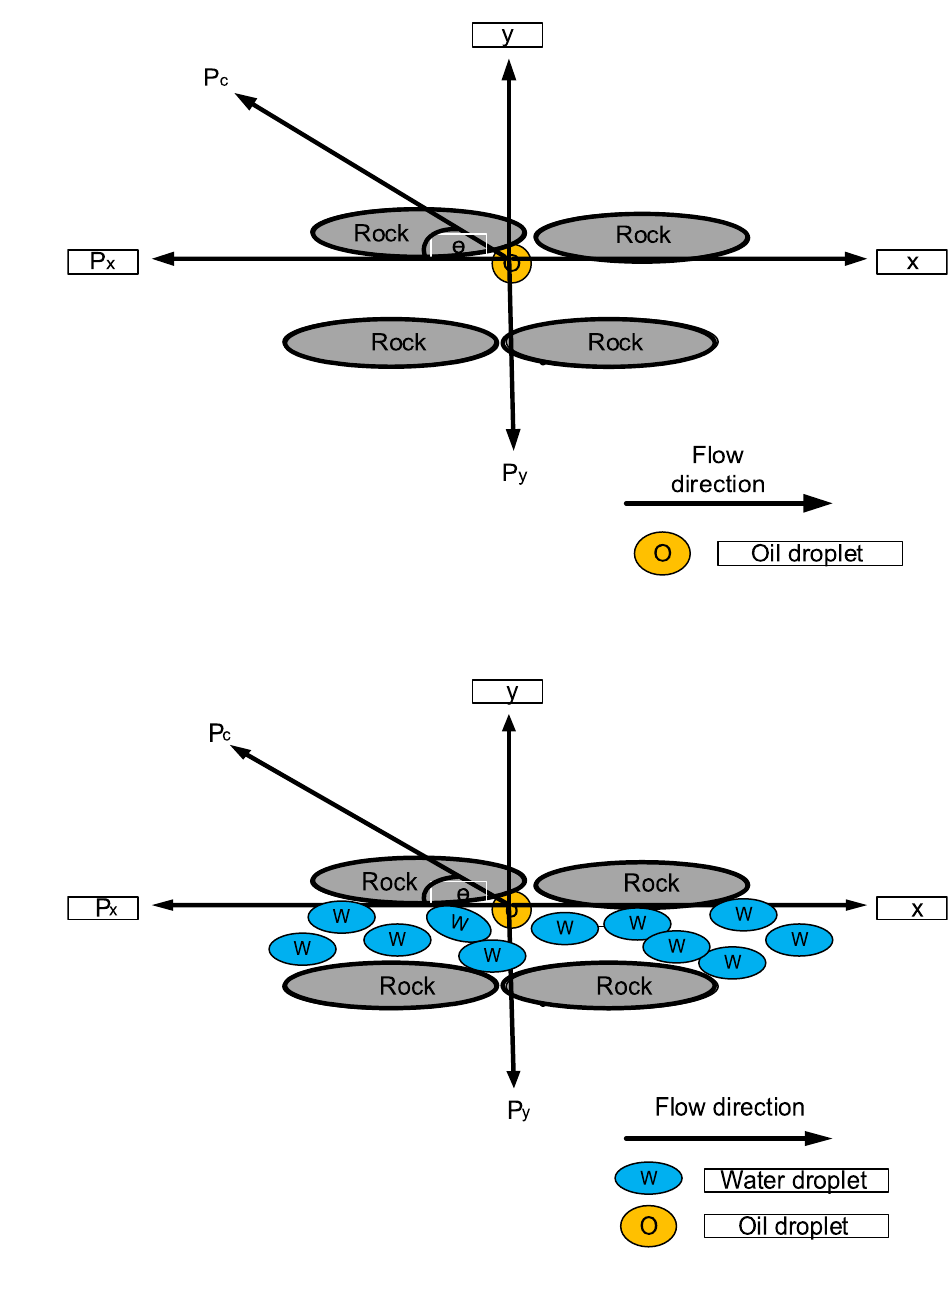
Fig. 5 Forces acting on an oil droplet when it hangs from the bottom surface of a rock with- out injection